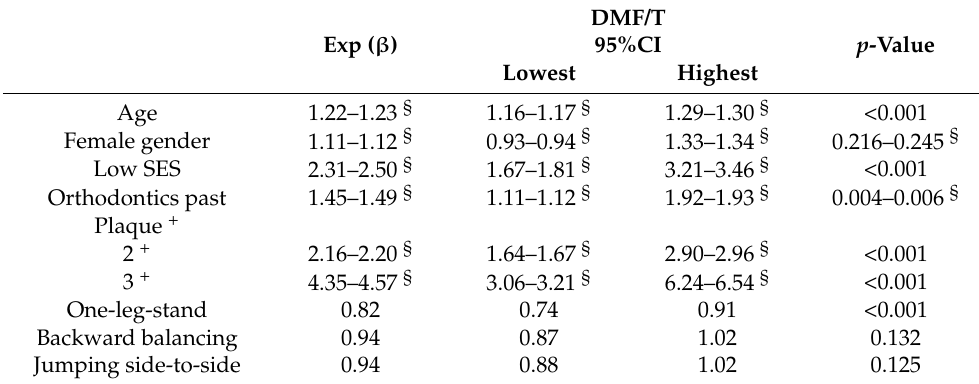
Table 4. Poisson regression analysis of dental caries experience (DMF/T) and SES, sex, age, orthodon- tic treatment, oral hygiene (plaque) and coordination skills in children and adolescents of 10 to 18 years (Leipzig, Germany).